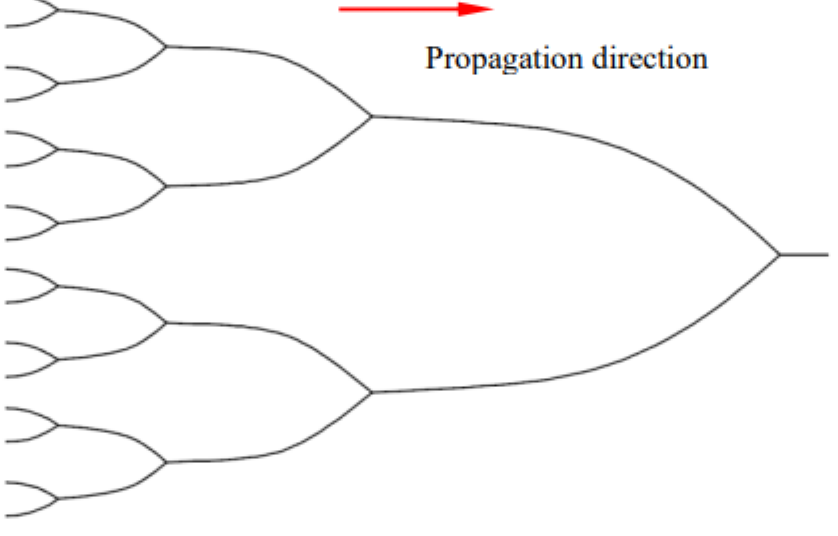
Figure 13. Ideal reverse binary tree pattern.